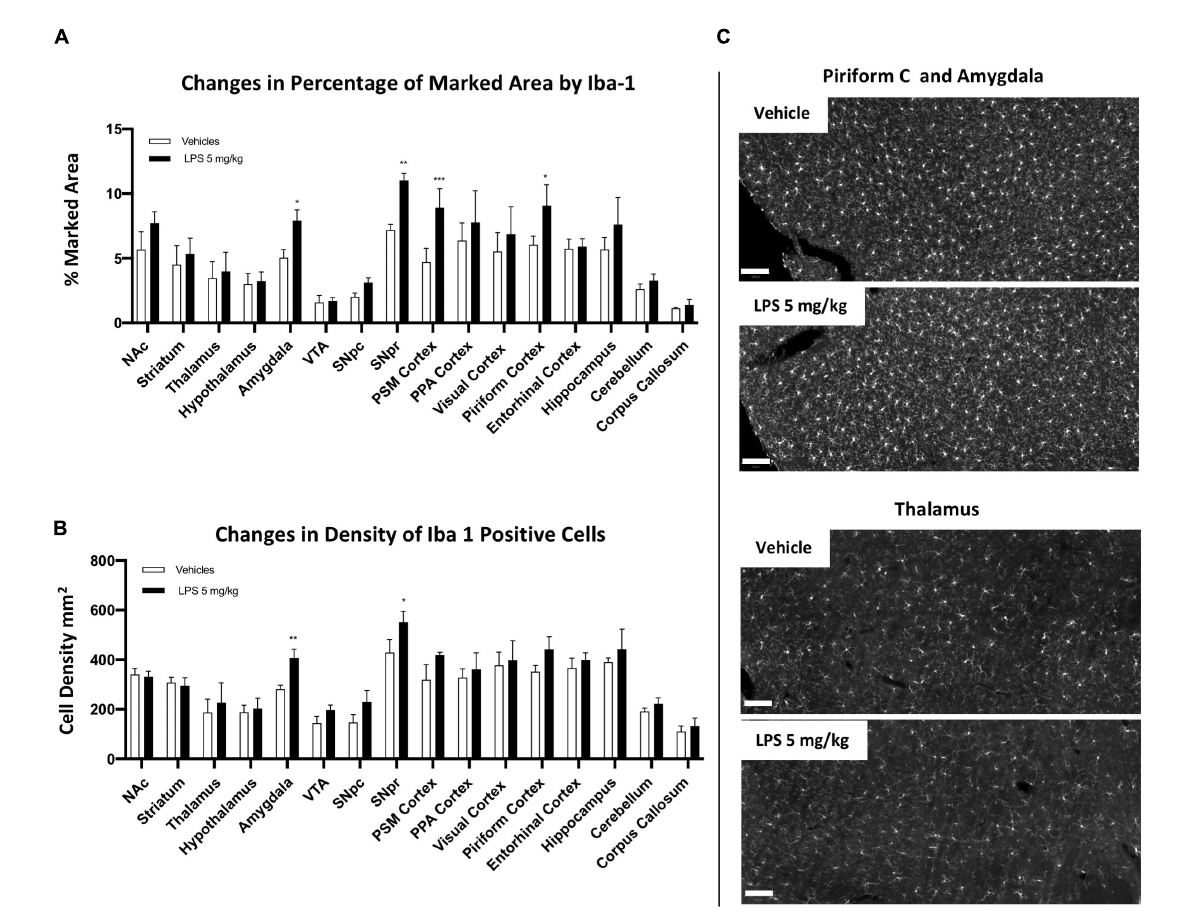
FIGURE4 Brain regional chronic microglial activation 1 month after 5 mg/kg i.p LPS administration. (A) Percentage of the marked area by Iba1 in vehicles (white columns) and LPS treated mice (black columns) 30 days post administration. Two-way ANOVA. F BrainRegions (15, 64) = 25.33, p < 0.0001; F Treatment (1, 64) = 44.38, p < 0.0001. F Interaction (15, 64) = 2.069, p < 0.0233, and n = 3 mice per region. Significance: (*) respect relative vehicles. (B) Iba1 positive cell density per mm 2 in vehicles (white columns) and LPS treated mice 30 days post administration (black columns). Two way ANOVA. F BrainRegions (15, 64) = 37.93, p < 0.0001; F Treatment (1, 64) = 32.59, p < 0.0001; F Interaction (15, 64) = 1.517, p < 0.1259, and n = 3 mice per region. Significance: (*) respect relative vehicles. (C) Representative images of Iba1 staining in piriform cortex, amygdala and thalamus. Scale bar = 100 um.